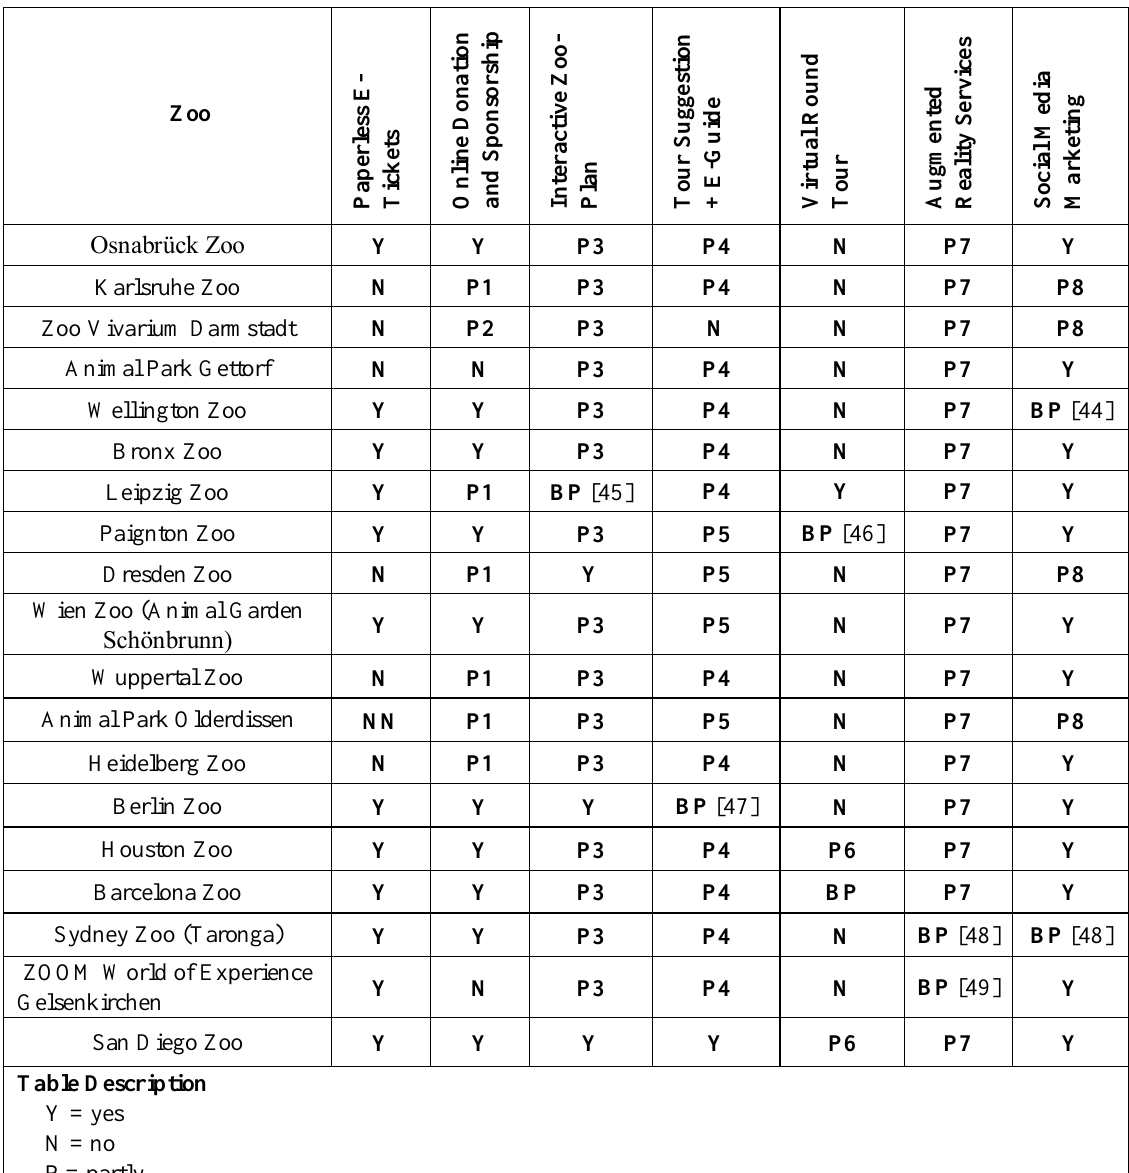
Table 1. Digital Potentials and Actions Zoos